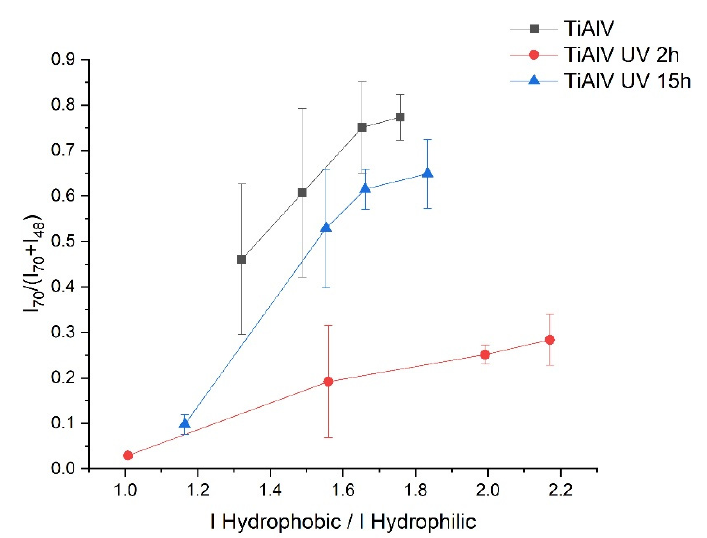
Figure 3. Ratio between peak intensities of amino acids with hydrophobic side chains (Met, Pro, Leu) and amino acids with hydrophilic side chains (His, Thr, Tyr) as a function of the amount of protein adsorbed (I 70 /(I 70 +I 48 )).